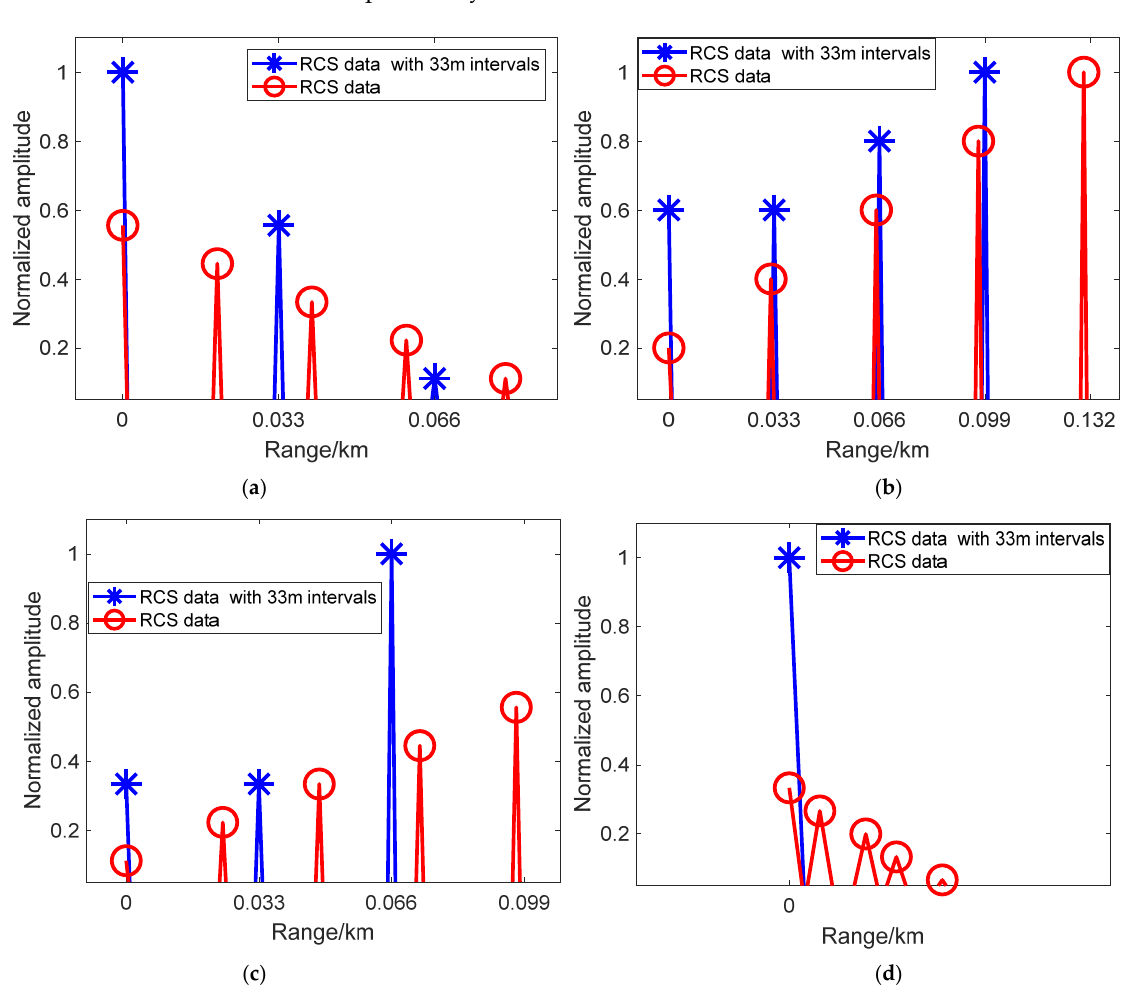
Figure 8. RCS data of point target 3 under the detection of 4 BDS satellites: ( a ) satellite 1; ( b ) satellite 2; ( c ) satellite 3; and ( d ) satellite 4.